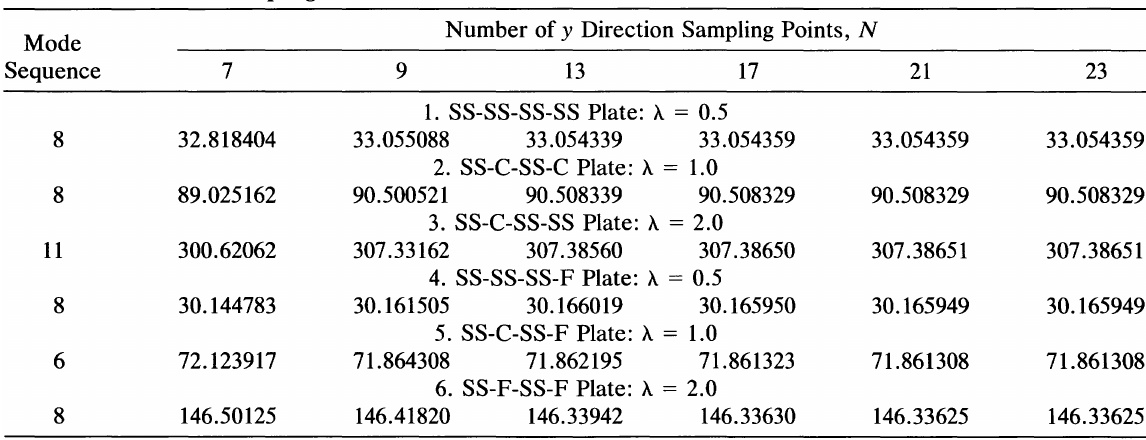
Table 2. Semianalyticai DQ Solution Convergence: Free Vibration Frequency of Thick Isotropic Rectangular Plates vs. Number of Sampling